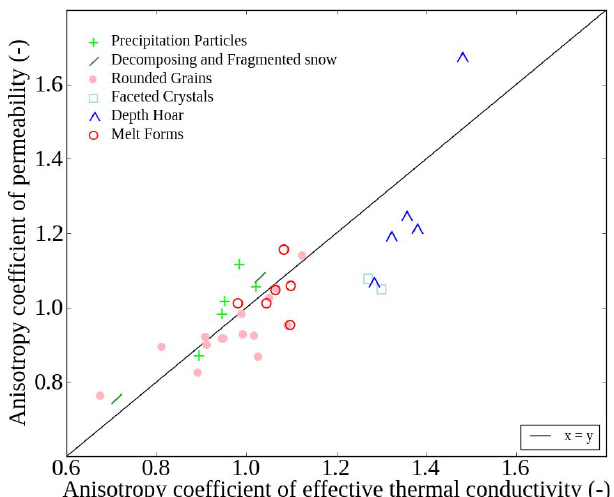
Fig. 3. Anisotropy coefficient computed for the intrinsic permeabil- ity A( K ) vs. that for the effective thermal conductivity A( k eff ) for the 35 samples considered in this study. Symbols and colors corre- spond to the ICSSG ( Fierz et al., 2009).